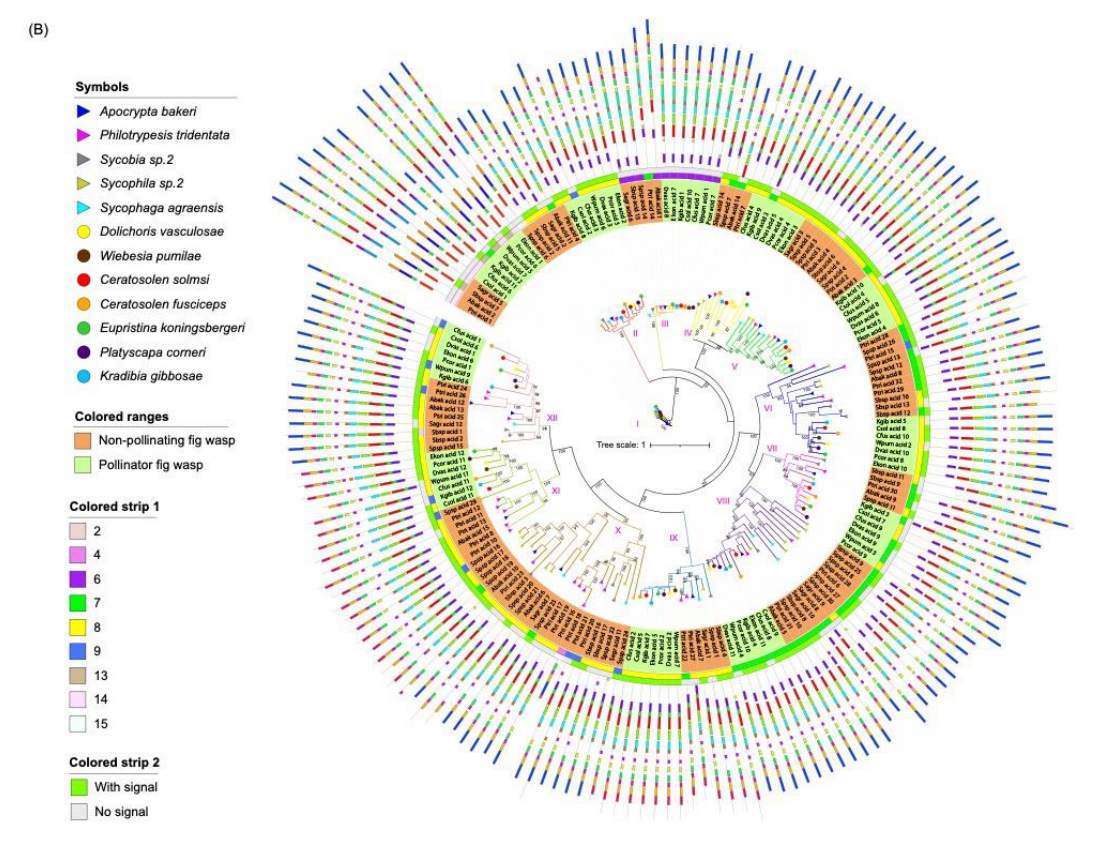
Figure 3. Phylogenetic tree of lipase proteins from 12 fig wasp species. ( A ) The ML tree depicts the evolutionary relationships among 259 neutral lipase protein sequences from 12 fig wasp species. From the inner to the outside: the first colored strip indicates the number of exons; the second colored strip indicates the length of the beta loop; the third colored strip indicates the length of the lid; the fourth colored strip indicates if the protein has secretion signal. ( B ) The ML tree depicts the evolutionary relationships among 182 acid lipase protein sequences from 12 fig wasp species. From the inner to the outside: the first colored strip indicates the number of exons; the second colored strip indicates if the protein has a secretion signal. The species names of fig wasps were indicated with different symbols. The background with orange indicates non-pollinating fig wasps and the background with green indicates pollinator fig wasps. The protein sequences for each motif are in supplementary Figure